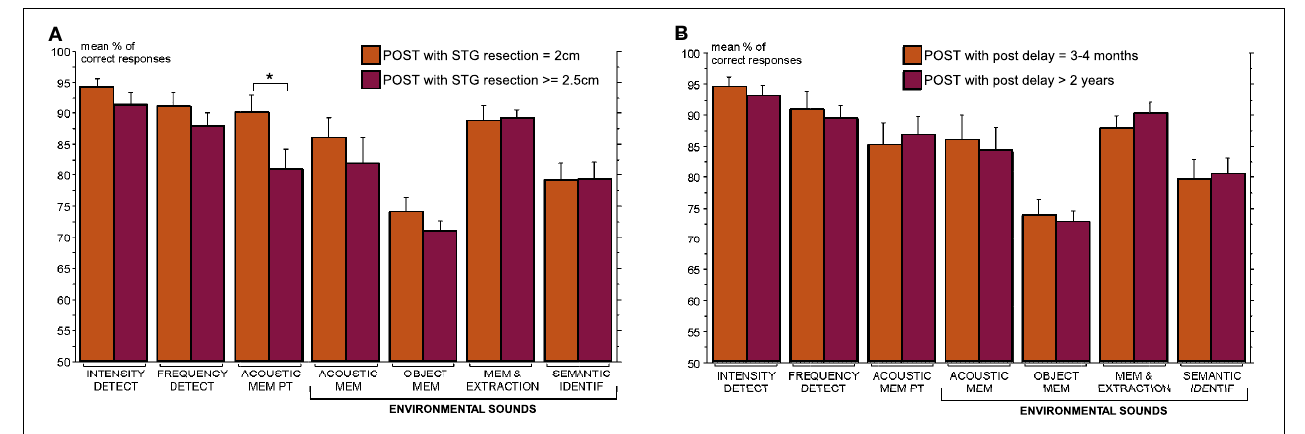
FIGURE 4 | Mean percentage of correct responses and standard error obtained for each auditory test in sub-groups of the POST group. (A) The POST group was fractionated into two sub-groups according to the STG resection extent: POST patients with a STG resection equal to 2 cm (orange, n = 11) and POST patients with a STG resection superior or equal to 2.5 cm (brown, n = 11). The only signifi cant difference between these two groups (Mann–Whitney tests) is indicated (* P < 0.05). (B) The POST group was